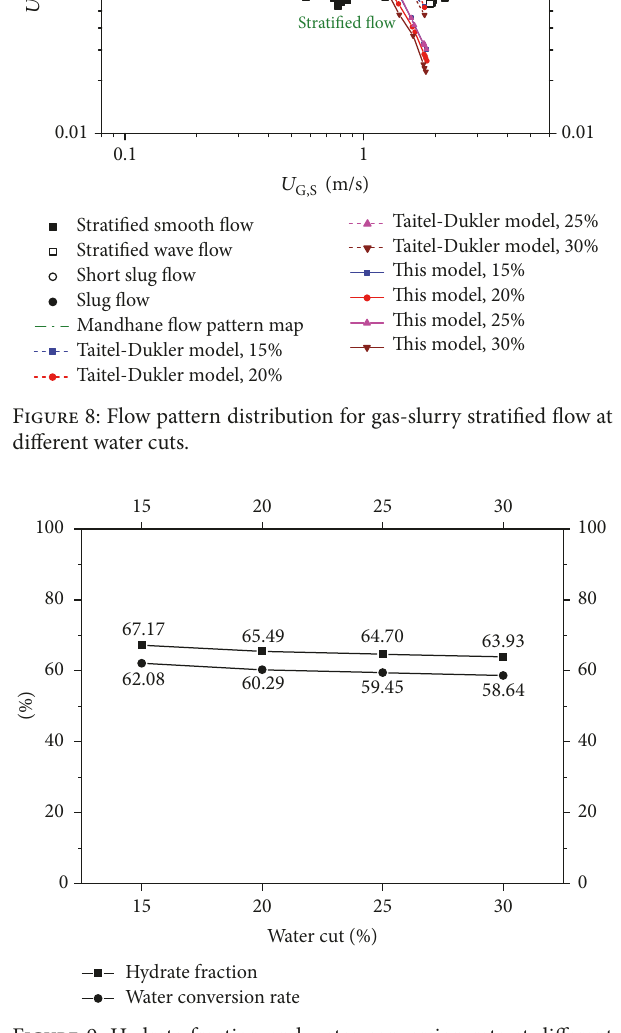
Figure 9: Hydrate fraction and water conversion rate at different water